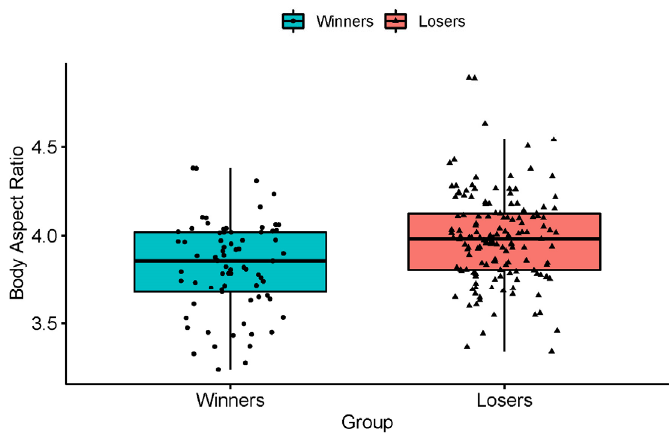
Figure 5. Body aspect ratio distribution.